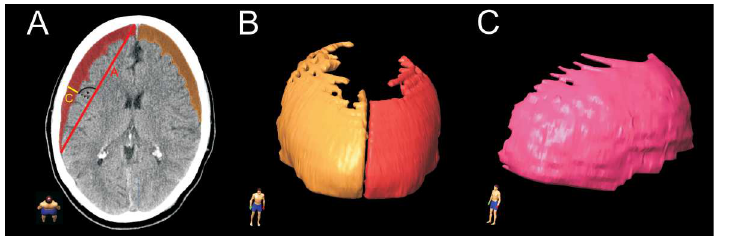
PLOS ONE | https://doi.org/10.1371/journal.pone.0199809 June 26,